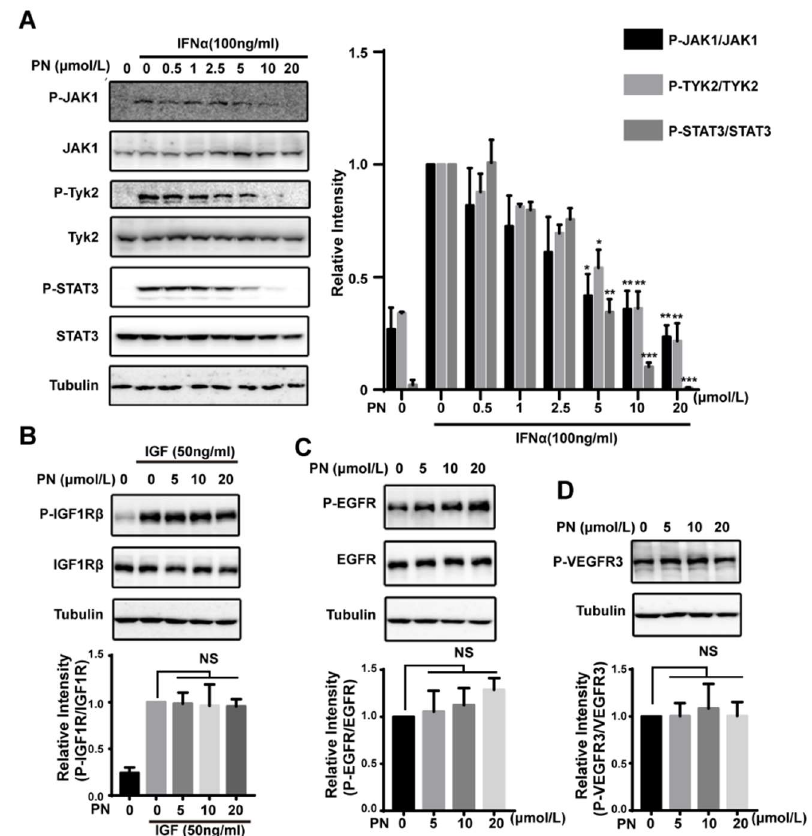
Figure 4. The effects of parthenolide on JAKs were selective. ( A ) Effects of PN on JAK1 and Tyk2 phosphorylation. MDA-MB-231 cells were treated with PN for 1 h before stimulation by IFNα for 10 min. Cell lysates were processed for Western blot analysis. ( B ) Effects of PN on the IGF1-induced IGF1Rβ phosphorylation. MDA-MB-231 cells were incubated with PN for 1 h and stimulated with IGF1 for 10 min. Cell lysates were processed for Western blot analysis. ( C , D ) Effects of PN on EGFR and VEGFR3 phosphorylation. MDA-MB-231 cells were incubated with PN for 1 h. Cell lysates were subjected to Western blot analysis. ( n = 3, NS = no statistical difference, * p < 0.05, ** p < 0.01, *** p < 0.001, One-way ANOVA). Table 1. Effects of 50 μmol/L parthenolide on the kinase activity of MAPK1, cSrc, PI3K, and EGFR. Kinase EGFR PI3K cSRC MAPK1 Activity (%) 116 107 91